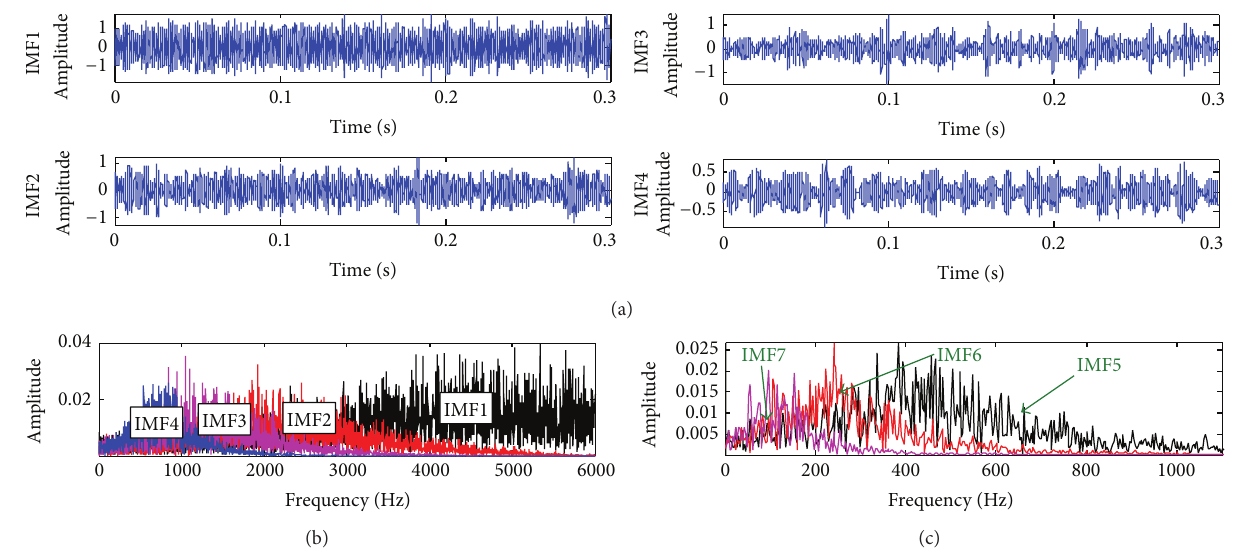
Figure 5: Decomposition results of the simulated signal shown in Figure 2(b) by EMD (a) waveform of IMF1 ∼ IMF4, (b) power spectrum of IMF1 ∼ IMF4, and (c) power spectrum of IMF5 ∼ IMF7.